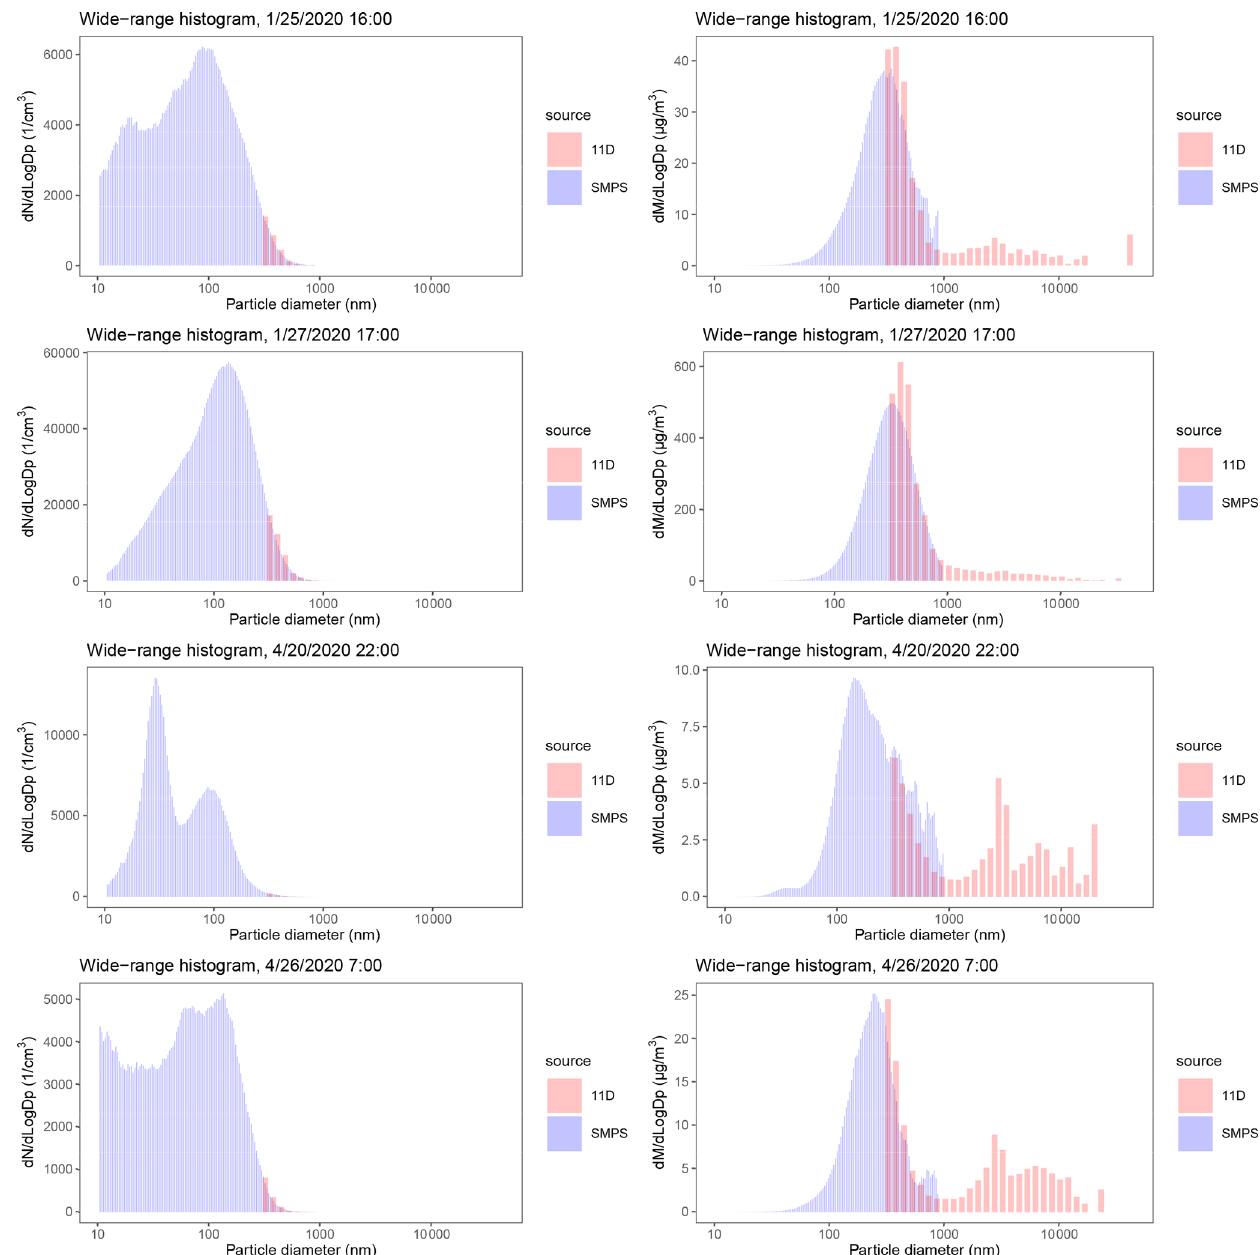
Figure 10. Wide-range histograms and hourly average values. Relative density 1.65 was applied to the SMPS to calculate mass of particles.